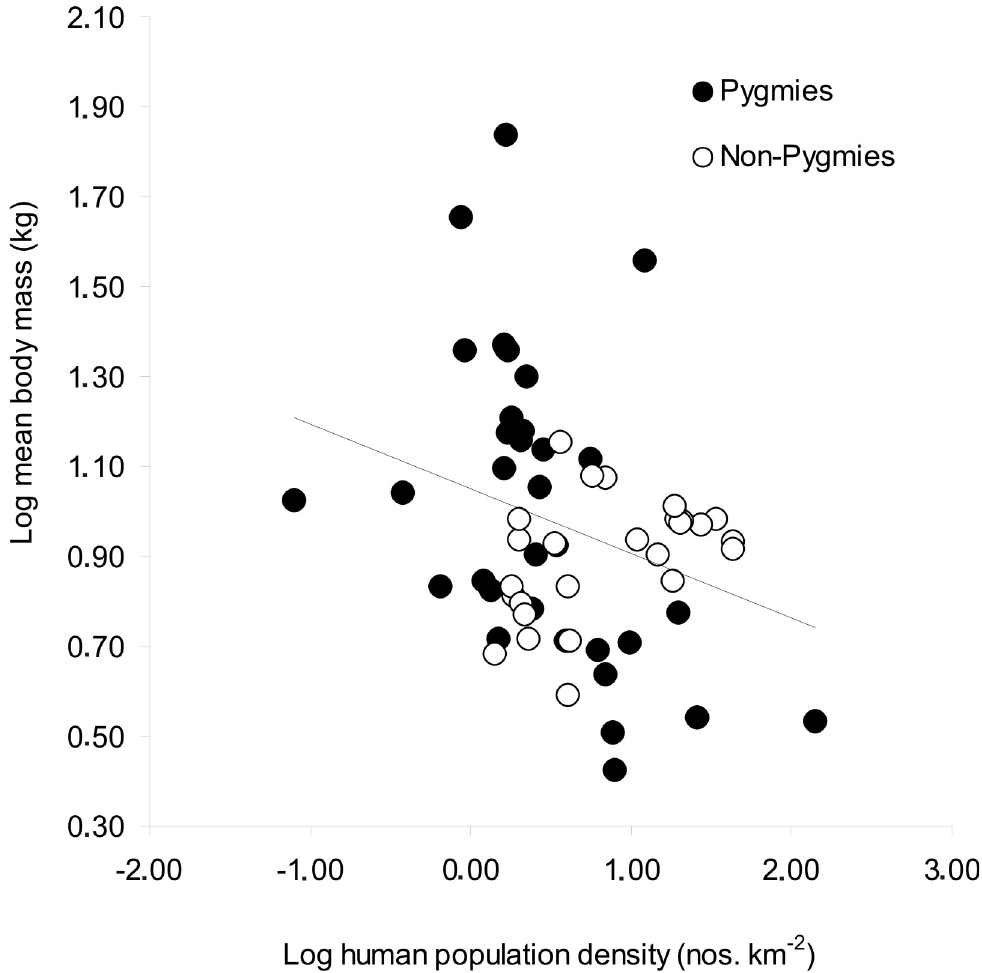
Fig 4. Relationship between mean body mass of mammals hunted in Pygmy and non-Pygmy sites and human population density in 20-km buffers around each site. Human population density is used here as a proxy for anthropogenic pressures in each study